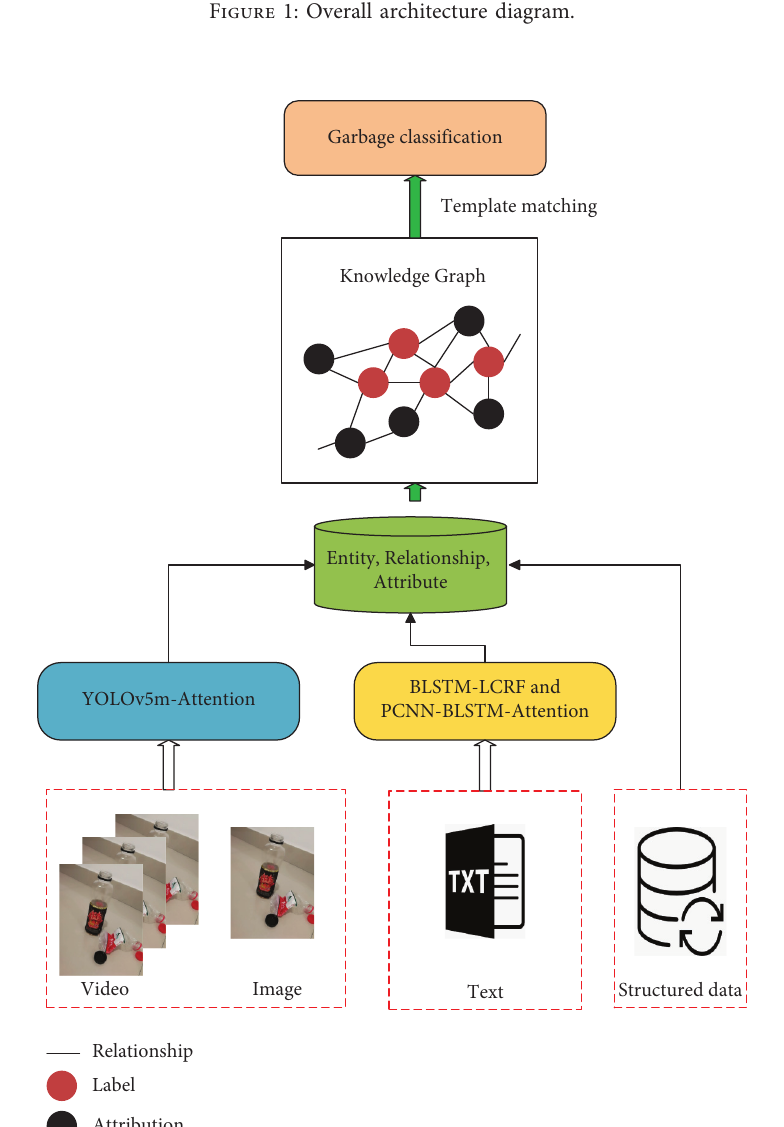
Figure 2: Visual scene understanding